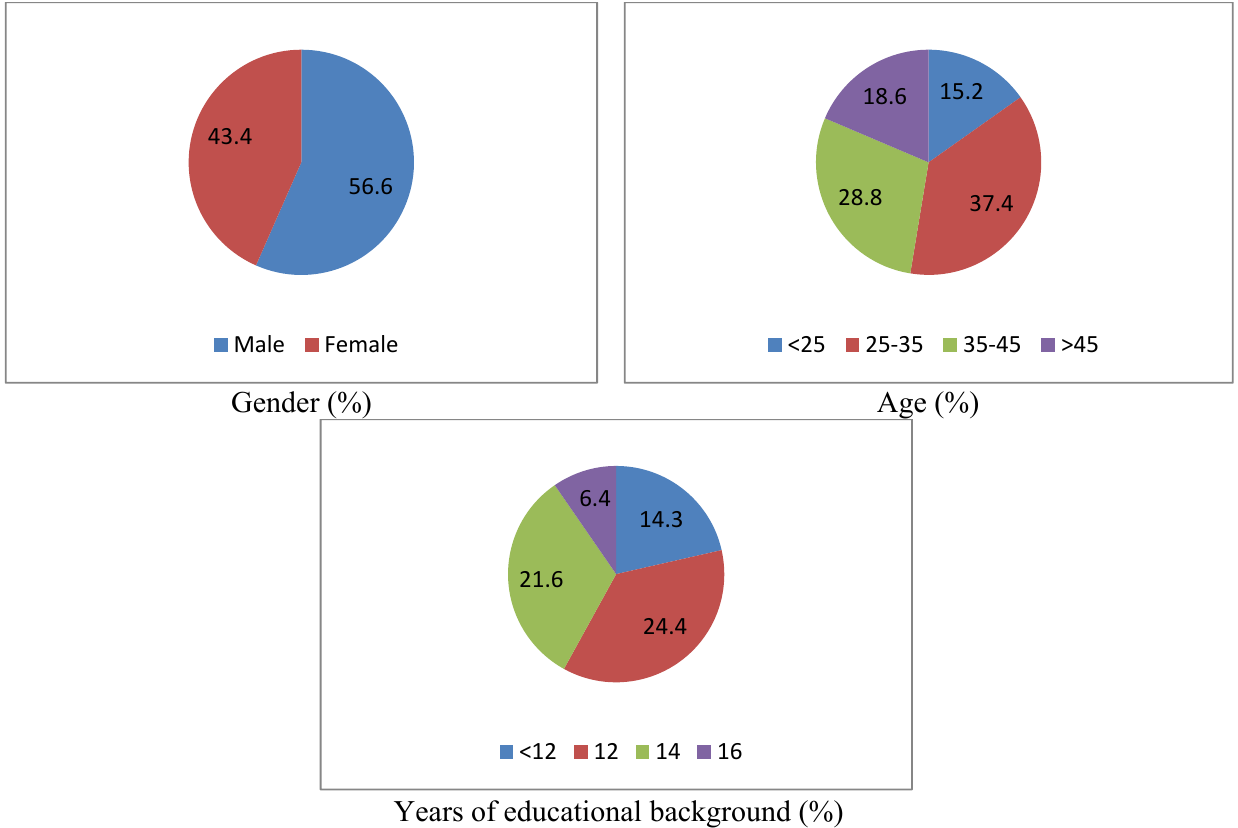
Fig. 2. Personal characteristics of the participants